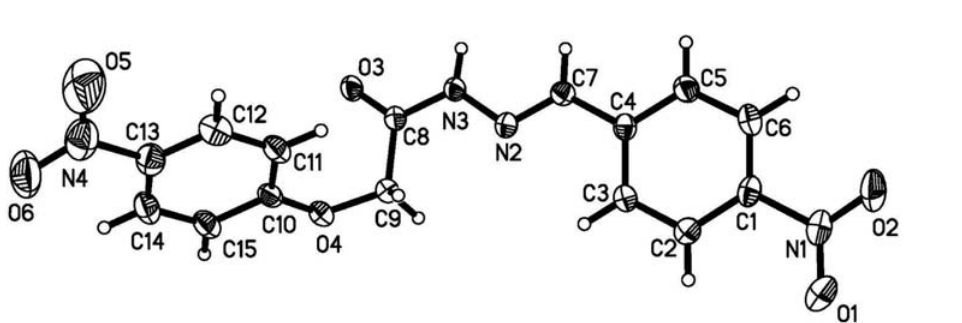
Figure 2. A perspective view of the molecular structure of 2 with the atom labeling scheme. Thermal ellipsoids are drawn at the 30% probability level.